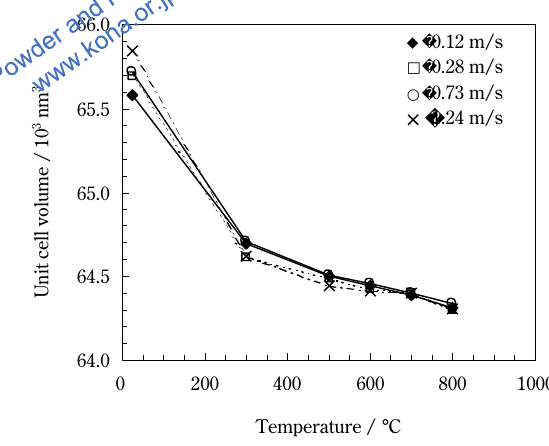
Fig. 13 Variation in unit cell volume of cubic-BaTiO 3 prepared by different mixing condition with